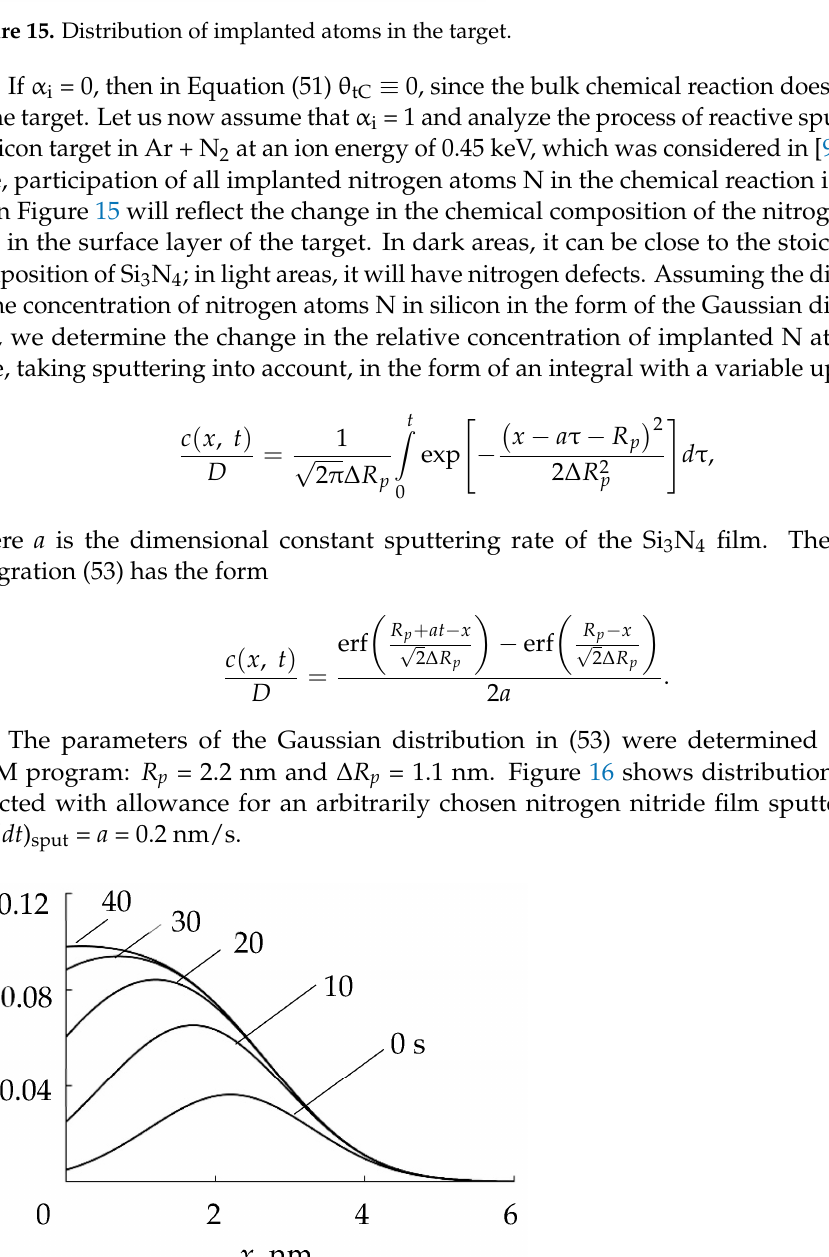
N + in silicon at energies 0.45 2 2